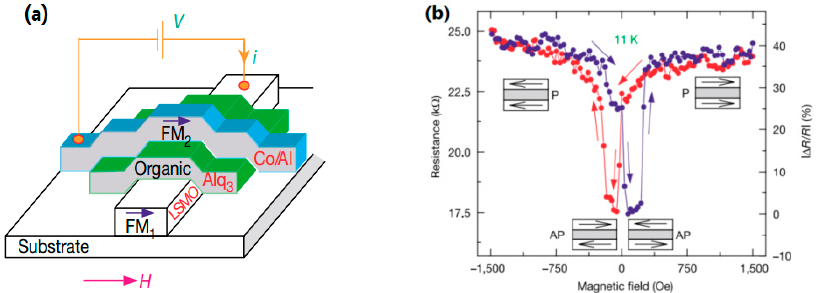
Figure 3. ( a ) Schematic diagram of a vertical spin valve consisting of a bottom LSMO electrode and a top Co electrode with the Alq 3 spacer. ( b ) Negative MR up to 40% in spin valve with 130 nm Alq 3 at 11 K. The blue (red) curve represents GMR measurements made with increasing (decreasing) magnetic field H. AP and P was dubbed as the magnetization of two FM electrodes. Adapted from [1], with permission from © 2004 Springer Nature.